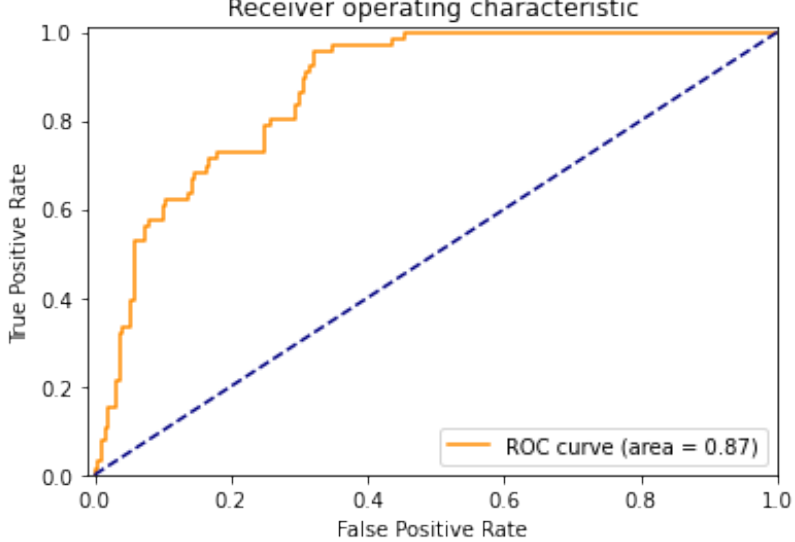
Figure 3. Representative receiver operating characteristic (ROC) curve for ImageNet-pretrained AI model classification of patient Age > 70 (yellow line). Note the ROC curve area, which indicates the achieved area under the ROC (AUROC). The performance of a hypothetical random classifier (AUROC = 0.5) is represented by the blue dashed line.